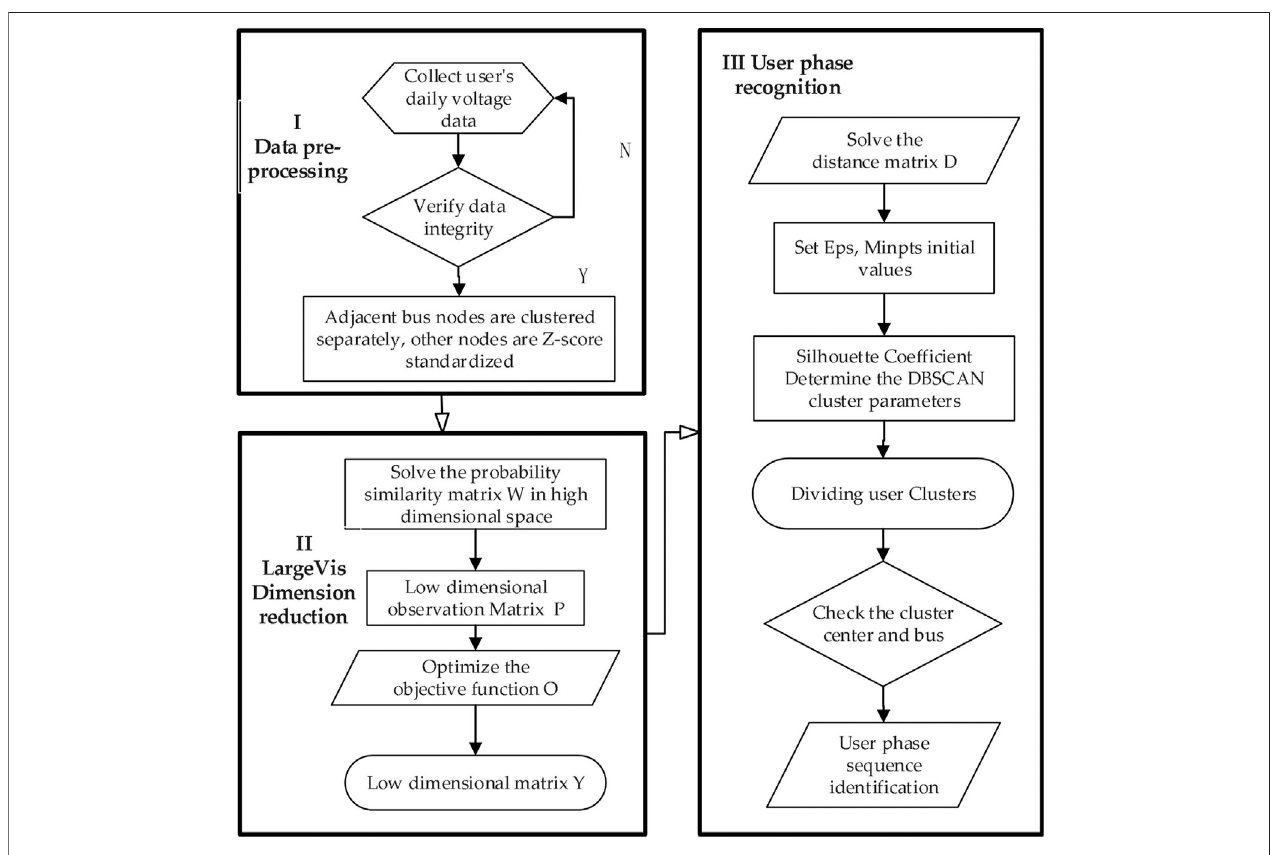
FIGURE 2 | Phase recognition algorithm process.